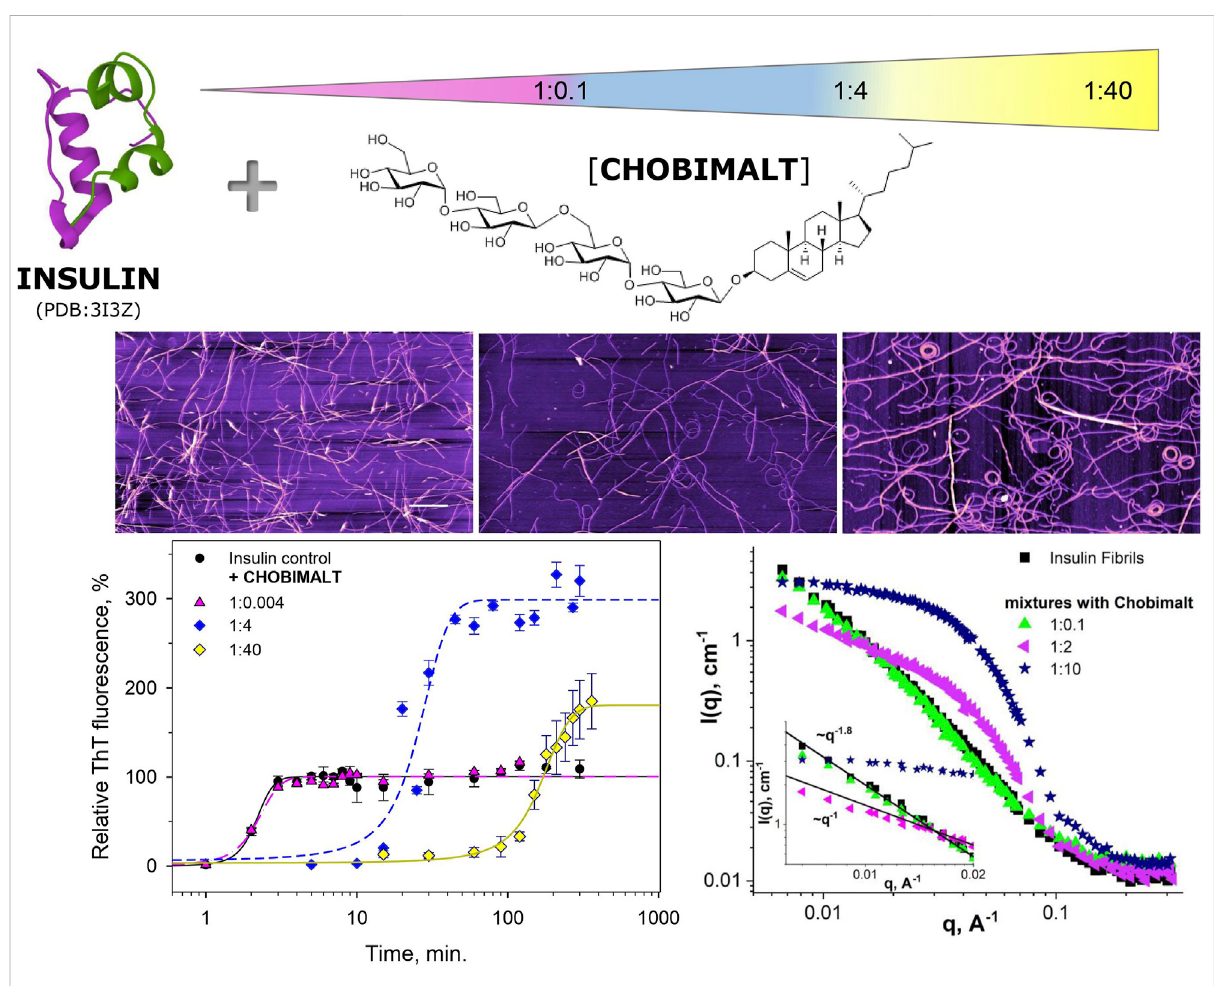
FIGURE 8 Schematic presentation of the effect of Chobimalt on insulin amyloid fi